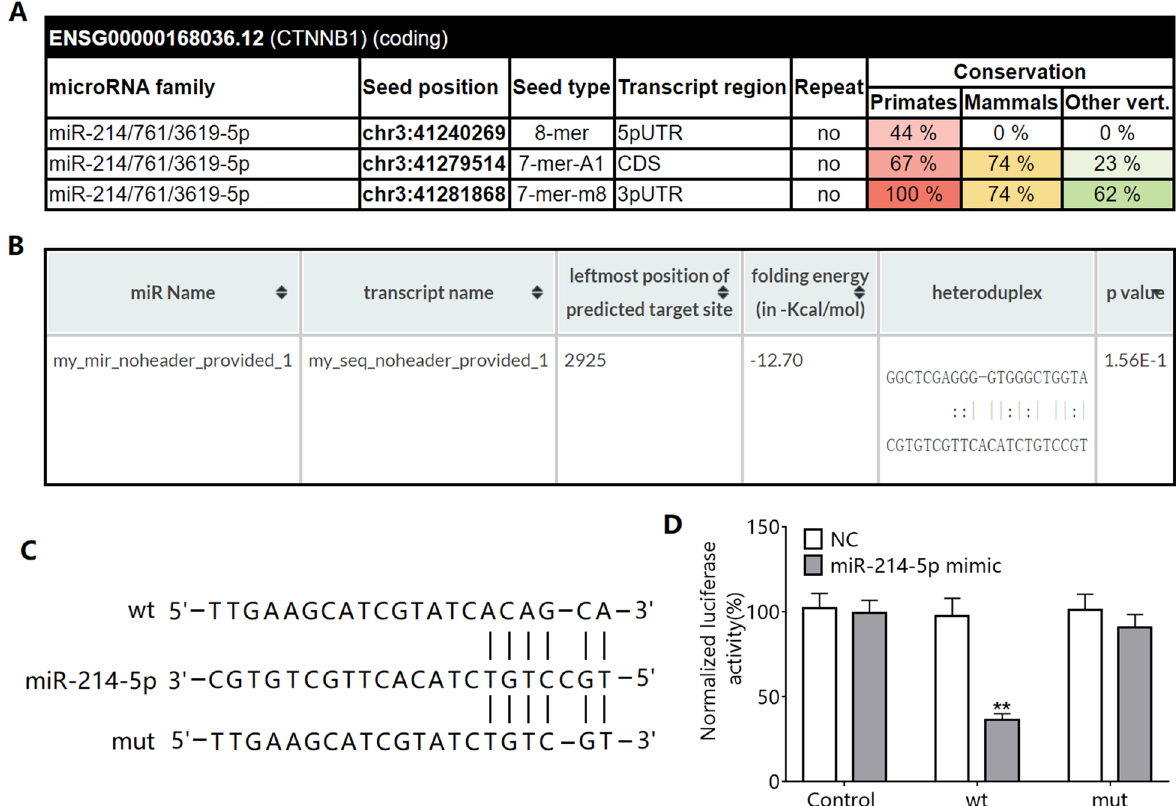
Figure 4. Bioinformatics prediction of the binding of CTNNB1 to miR-214-5p. ( A ) miRcode predicted miR- 214-5p-binding sites in CTNNB1 mRNA and the conservation of the binding sites among species. ( B ) RNA22 v2 predicted the sequence of the miR-214-5p-binding site in CTNNB1 mRNA. ( C ) 3 ′ -UTR of CTNNB1 mRNA and miR-214-5p seed region complementary paired sequence. ( D ) The dual luciferase reporter gene experiment verifies the interaction between miR-214-5p and 3 ′ -UTR of CTNNB1 mRNA and the functions. ** P < 0.01 compared to NC. CTTNB1 : gene encoding the β-catenin